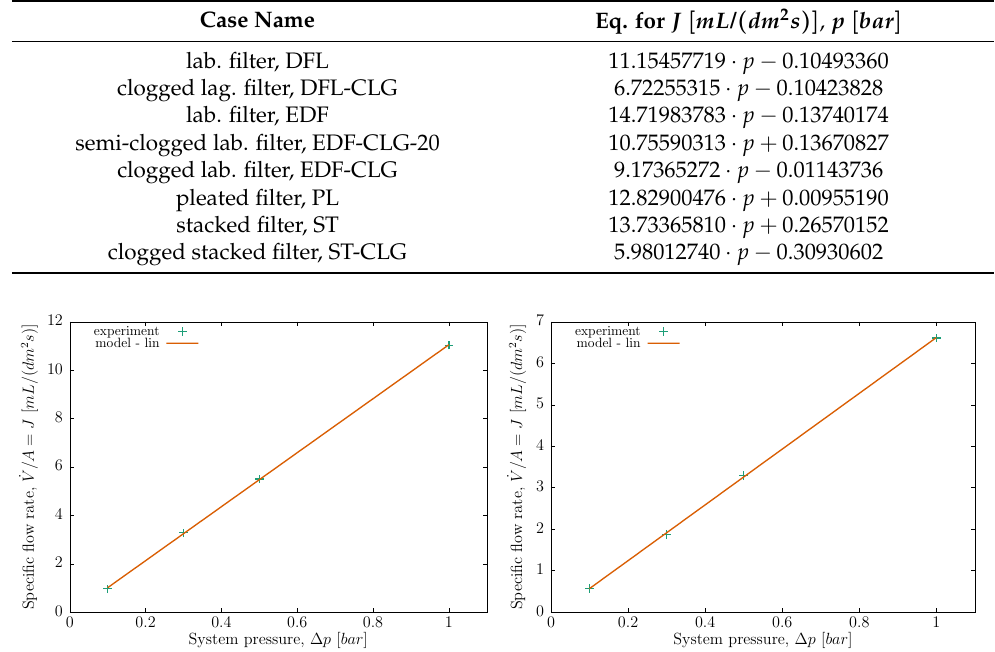
Table 4. Models for specific flow rate valid for system pressure in the rage of 0.1 < ∆ p < 1. Experiments based on which the models were developed were performed with distilled water.